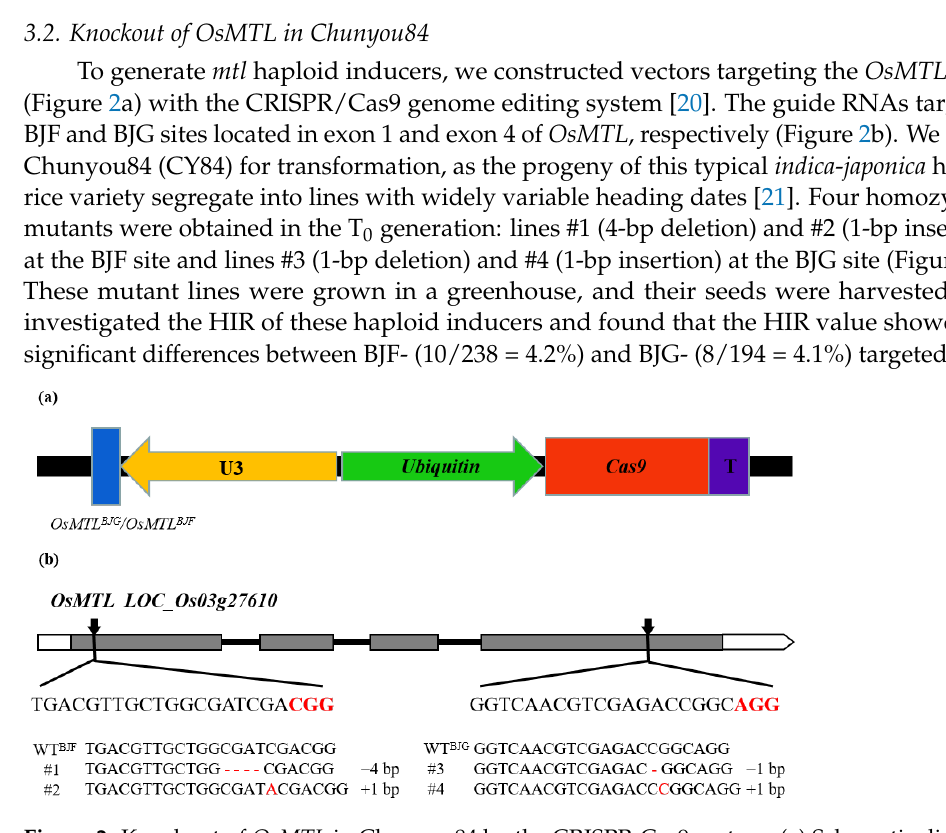
Figure 1. Flow chart of the method used to develop multiple-heading-date mtl haploid inducer lines in rice.